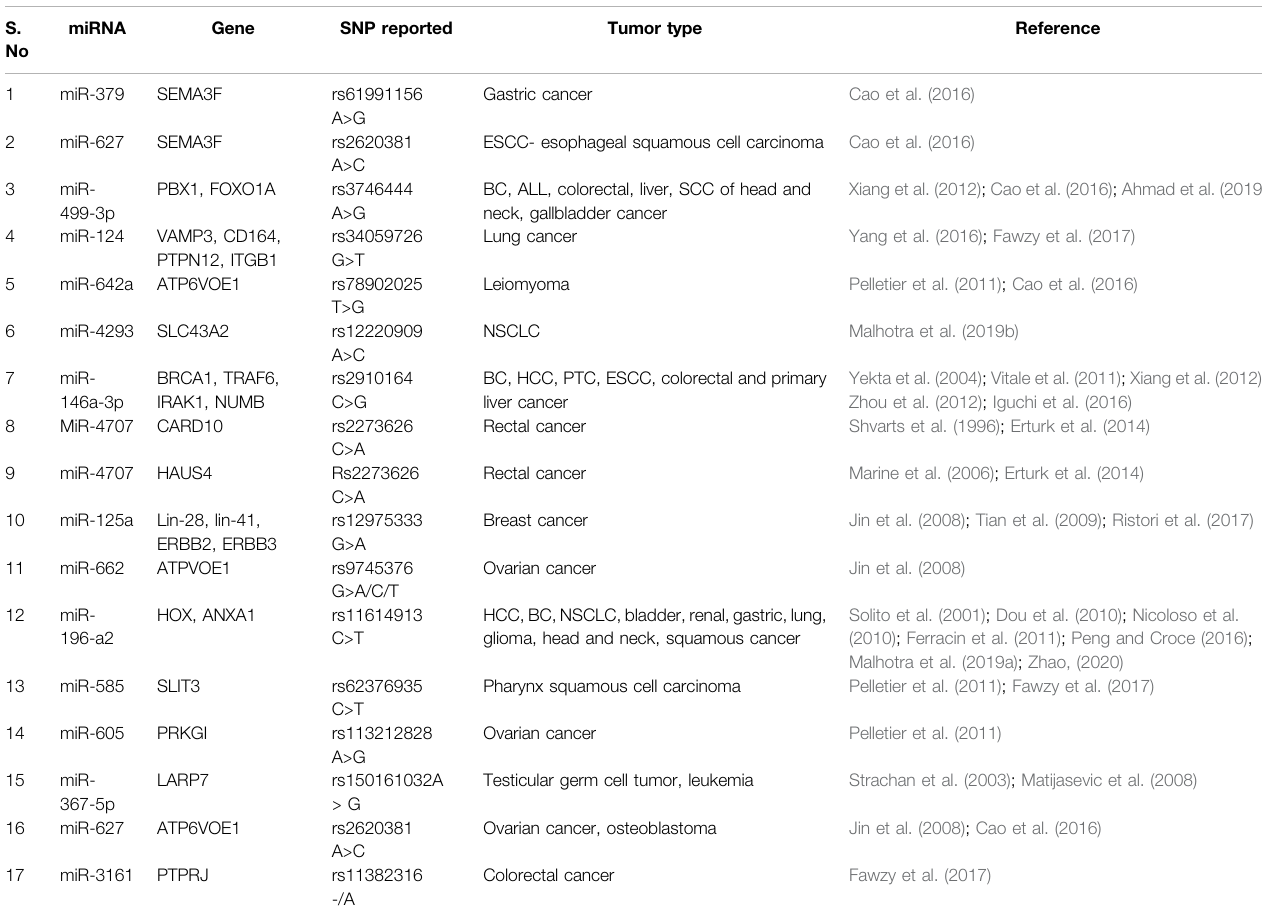
TABLE 1 | SNPs reported in seed sequence of miRNA in various